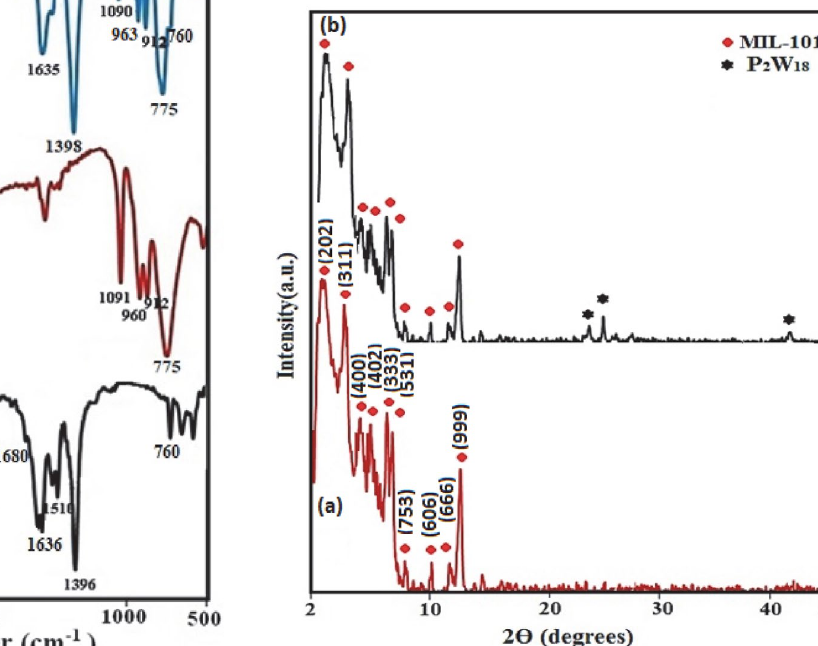
Figure 2. XRD patterns of (a) MIL-101(Cr) and (b) P 2 W 18 @MIL- 101(Cr)